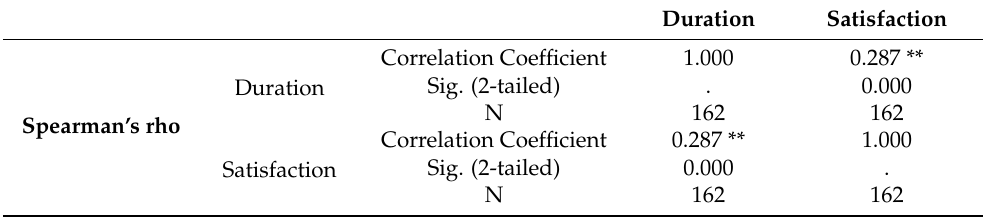
Table 8. Spearman’s rank correlation coefficient between duration and satisfaction level.